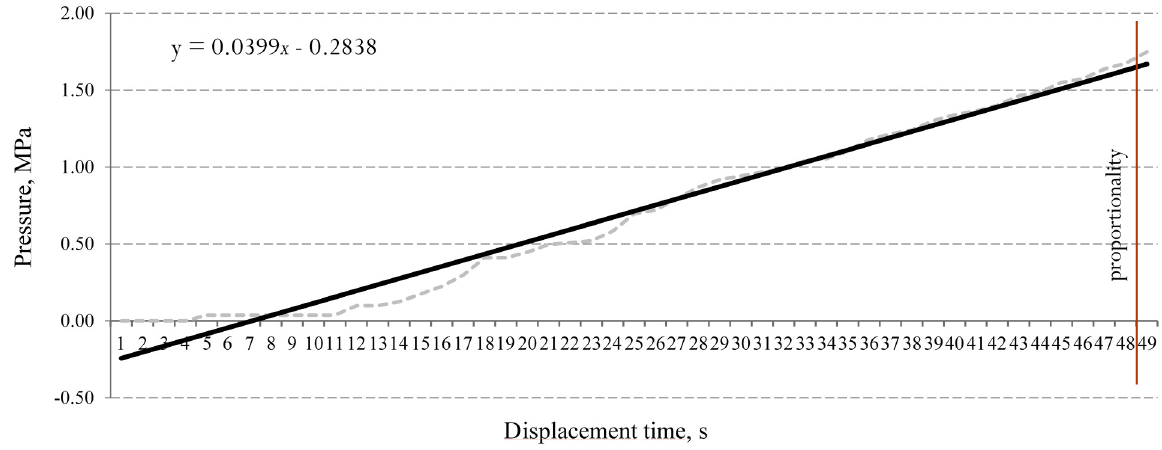
Figure 5. The resultant strengths in part A.